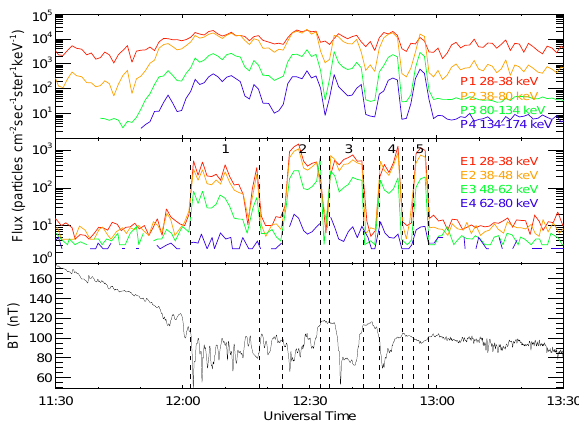
Fig. 9. The top and middle panels contain the proton and electron flux, respectively, for four energy channels summed over all PA, as measured by ISEE-2. The five zones of increased electron flux are marked with vertical dotted lines and labeled. The bottom panel shows the total local magnetic field strength.